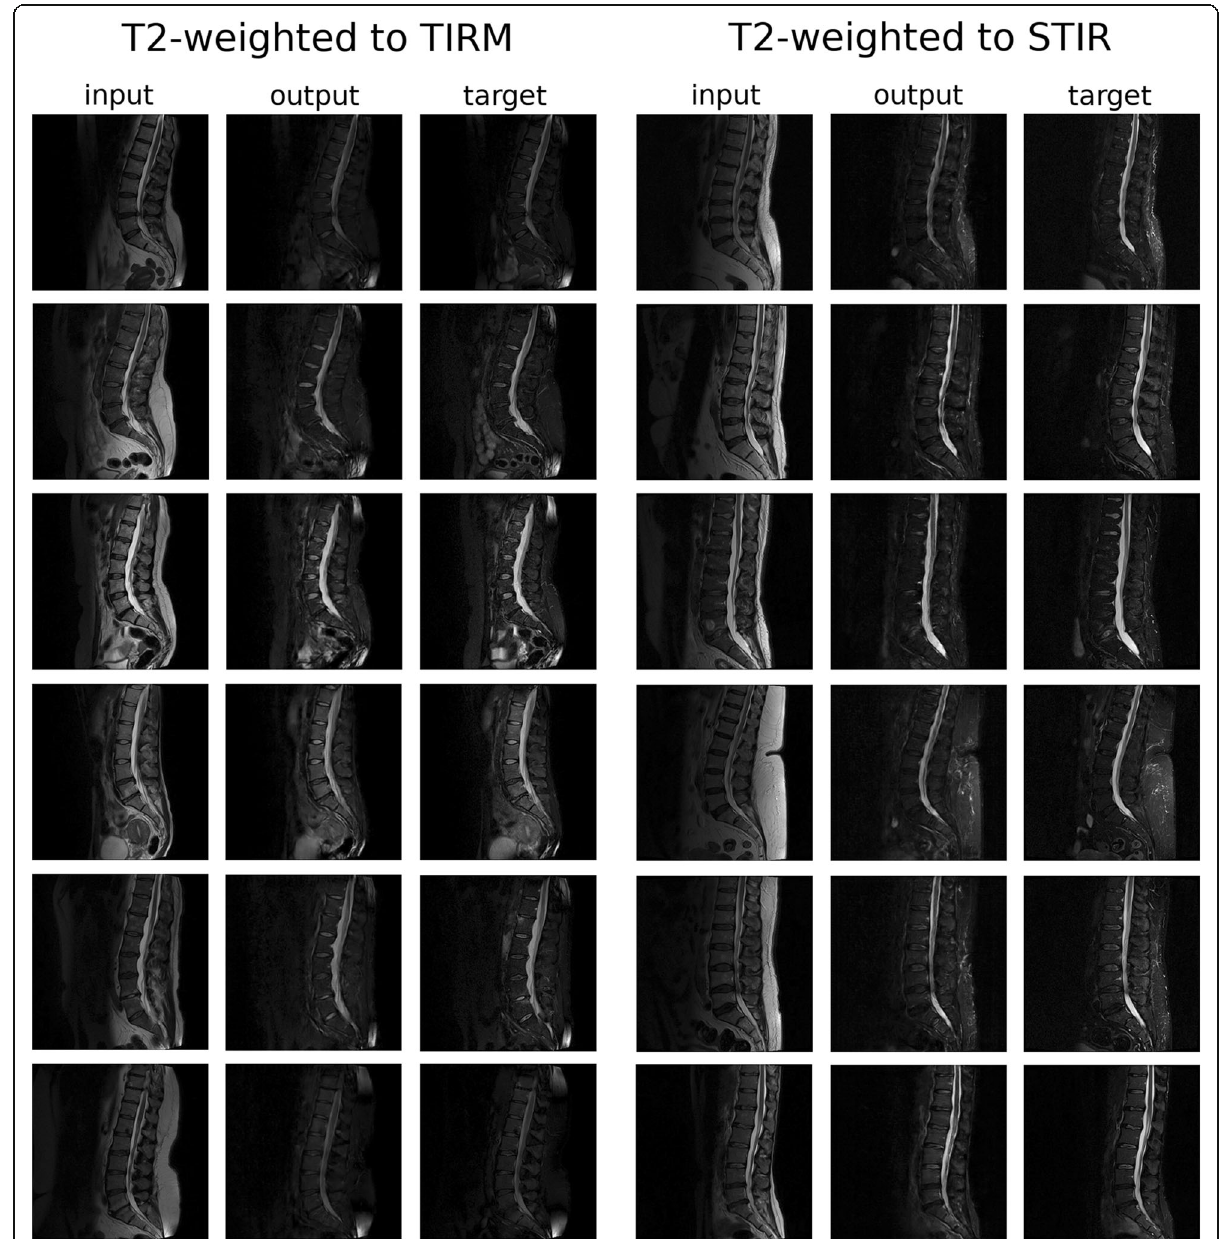
Fig. 5 Representative results of the translation from T2W MRIs to TIRM ( left ) and to STIR ( right ) images. input: original T2W image; output: TIRM/ STIR image created by the generative model; target: original TIRM/STIR image. Images from six exemplary patients are shown for each